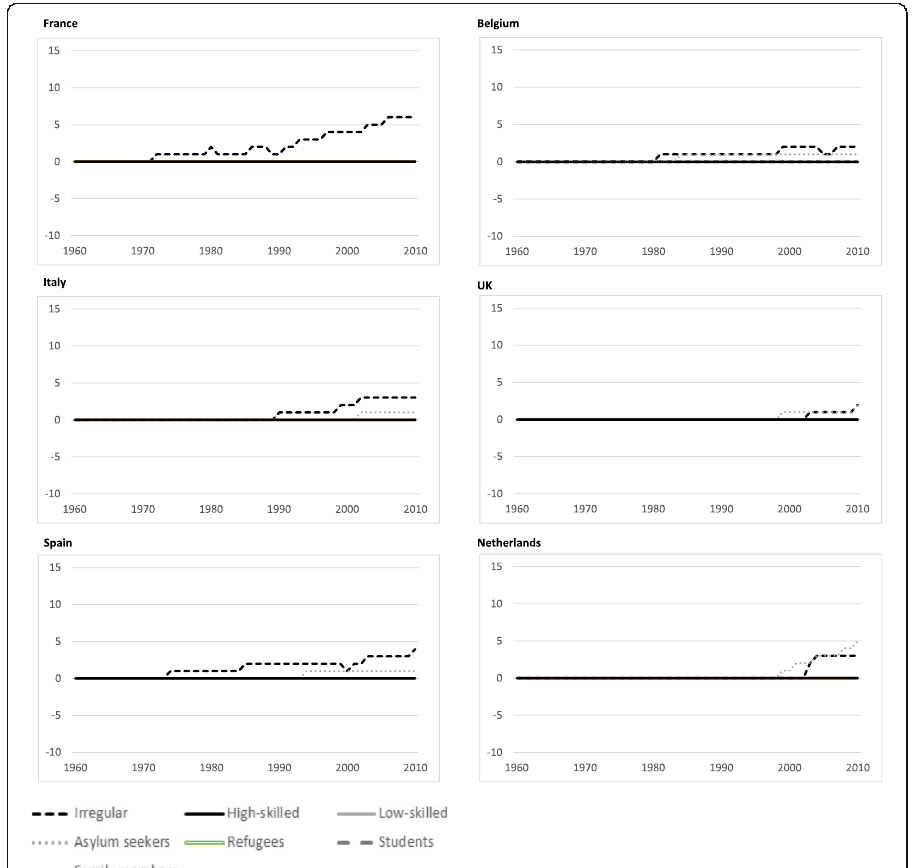
Fig. 5 Return of non-European migrants: migration policy changes in Belgium, UK, France, Italy, Pain and the Netherlands, 1960 – 2010. Note: Positive values on vertical axis = more restrictive. Negative values on vertical axis = less restrictive. Source: DEMIG POLICY database recoded by the